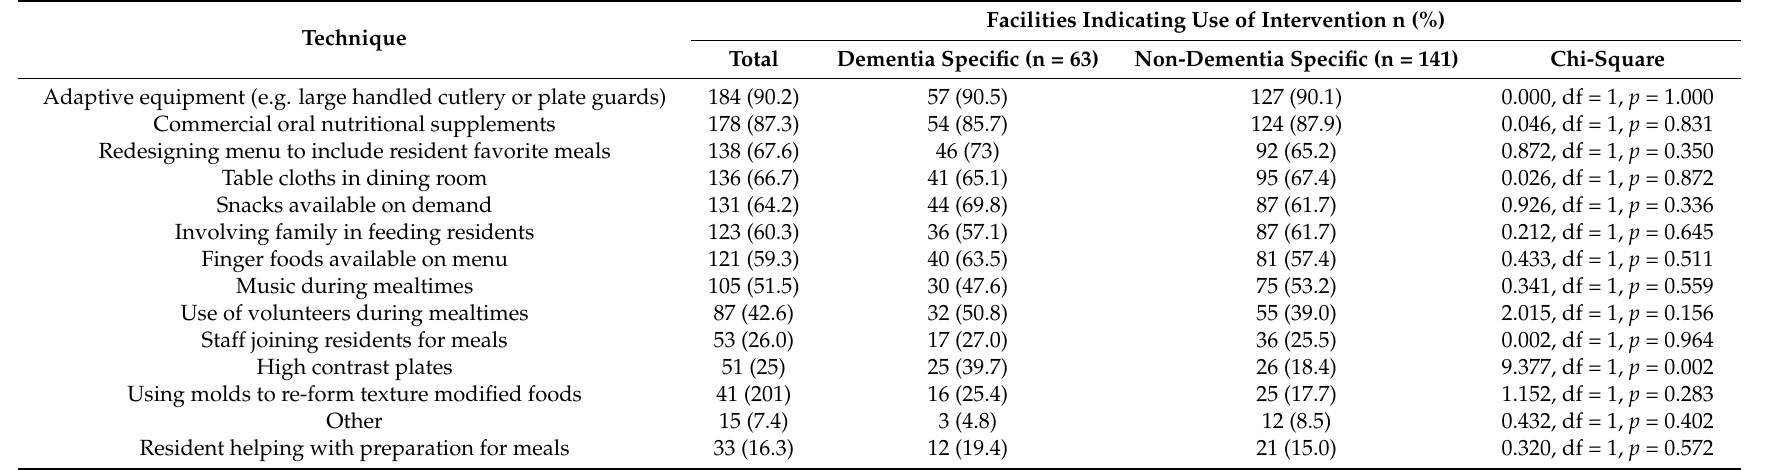
Table 3. Use of supportive mealtime interventions in dementia specific and nonspecific